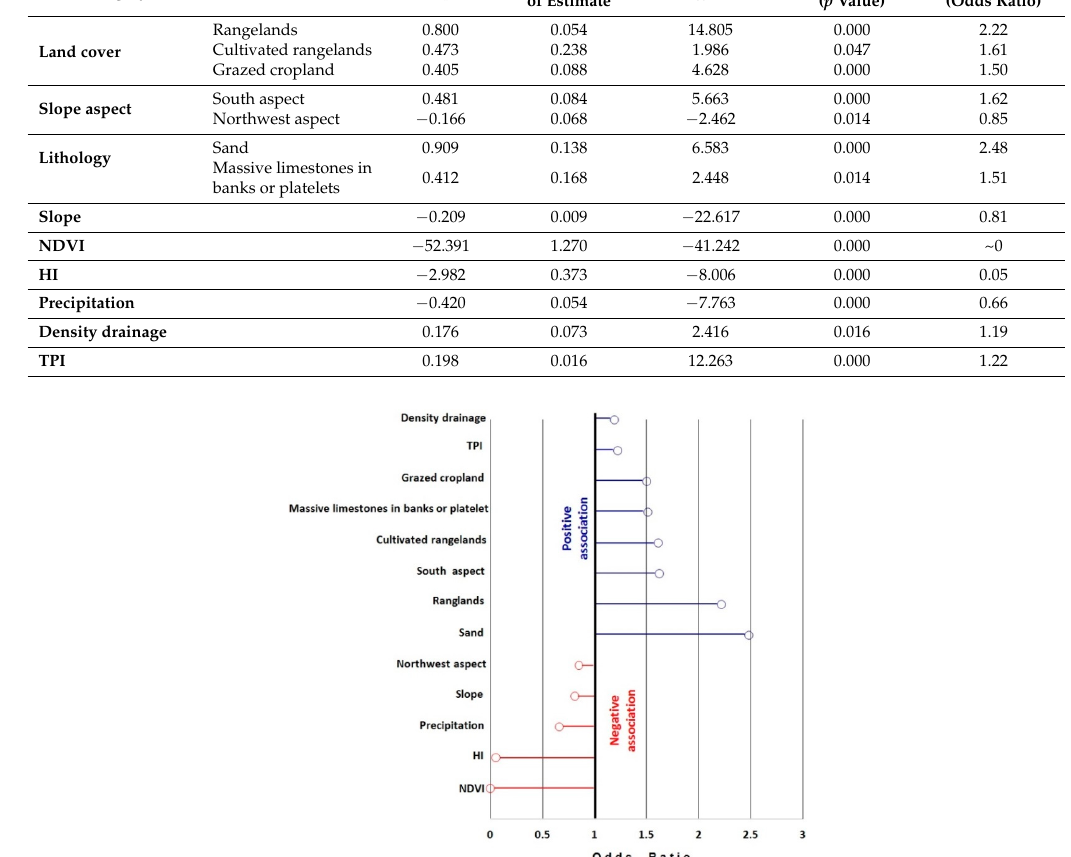
Table 4. The predictive factors retained in the final logistic model and their estimated coefficients.